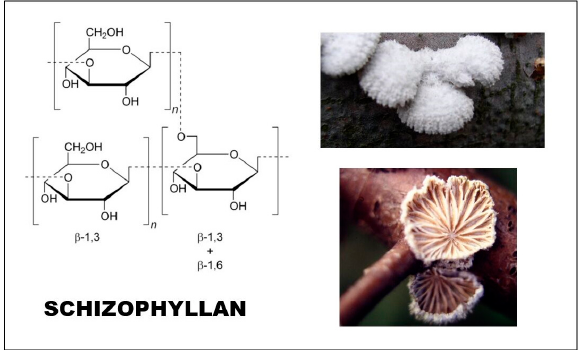
Figure 4. The schizophyllan glucan from Schizophyllum commune (split gill